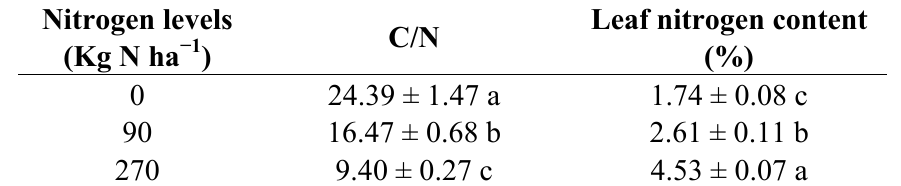
Table 4. Effects of nitrogen levels on C/N ratio and leaf nitrogen content in L. pumila.